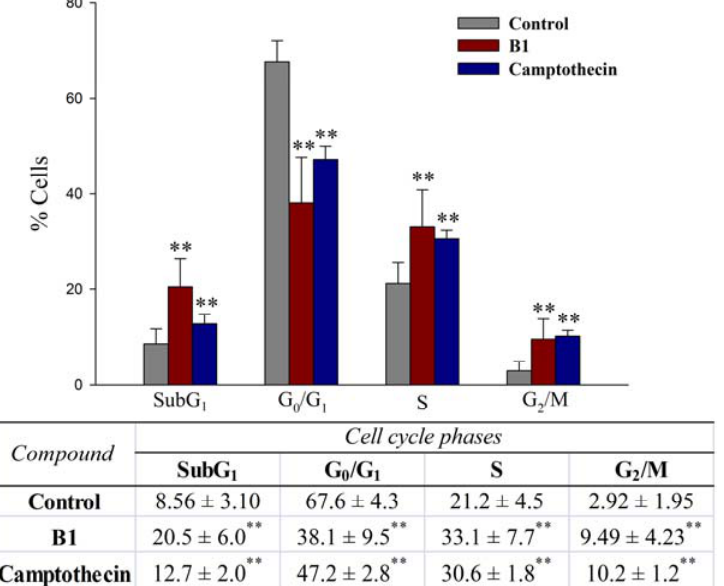
Figure 6. Cell cycle profile of MCF-7 cells after 48 h treatment with compound B1 and camptothecin at 25 μ M. Each bar represents the mean of three independent experiments and error bars indicate the standard deviation. ** p < 0.01 with respect to the